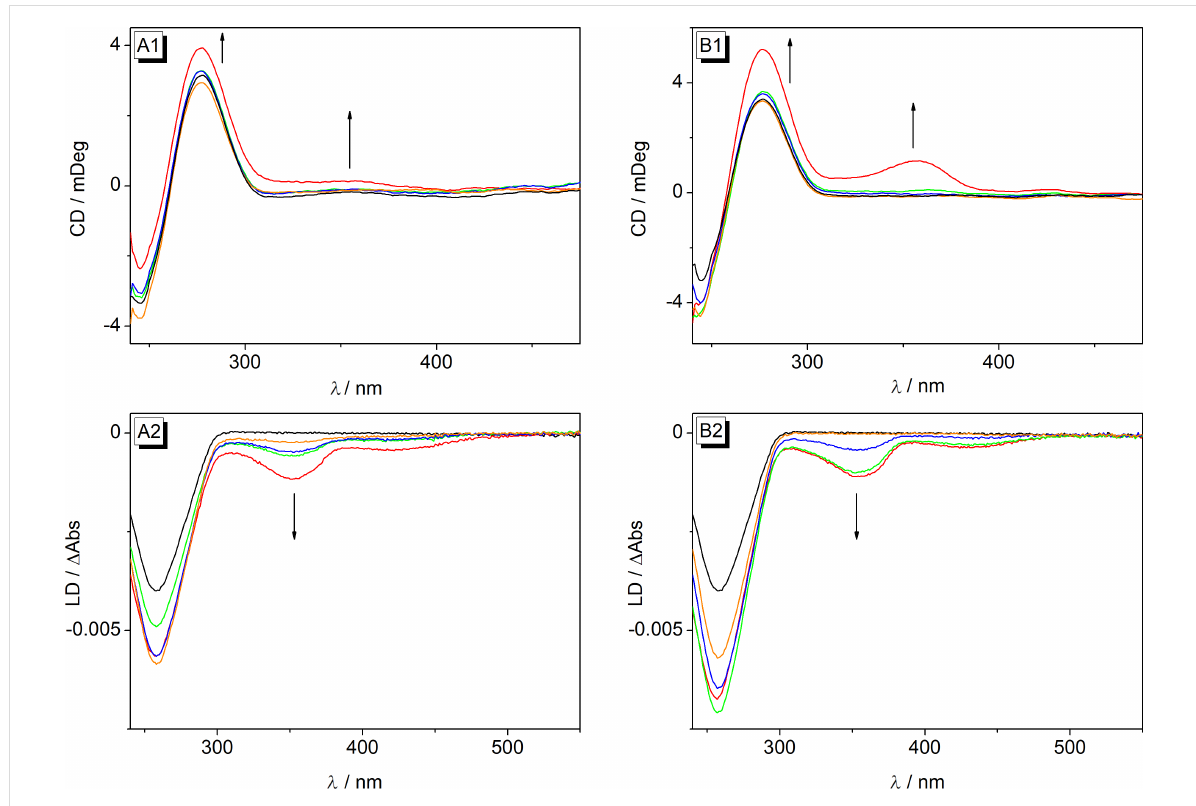
Figure 5: CD and LD spectra of ct DNA (1 and 2, c DNA = 20 μ M; in BPE buffer: 10 mM, pH 7.0; with 5% v/v DMSO) in the absence and presence of 5a (A), and 5d (B) at LDR = 0 (black), 0.05 (orange), 0.2 (blue), 0.5 (green), 1.0 (red). The arrows indicate the changes of CD and LD bands with in- creasing LDR